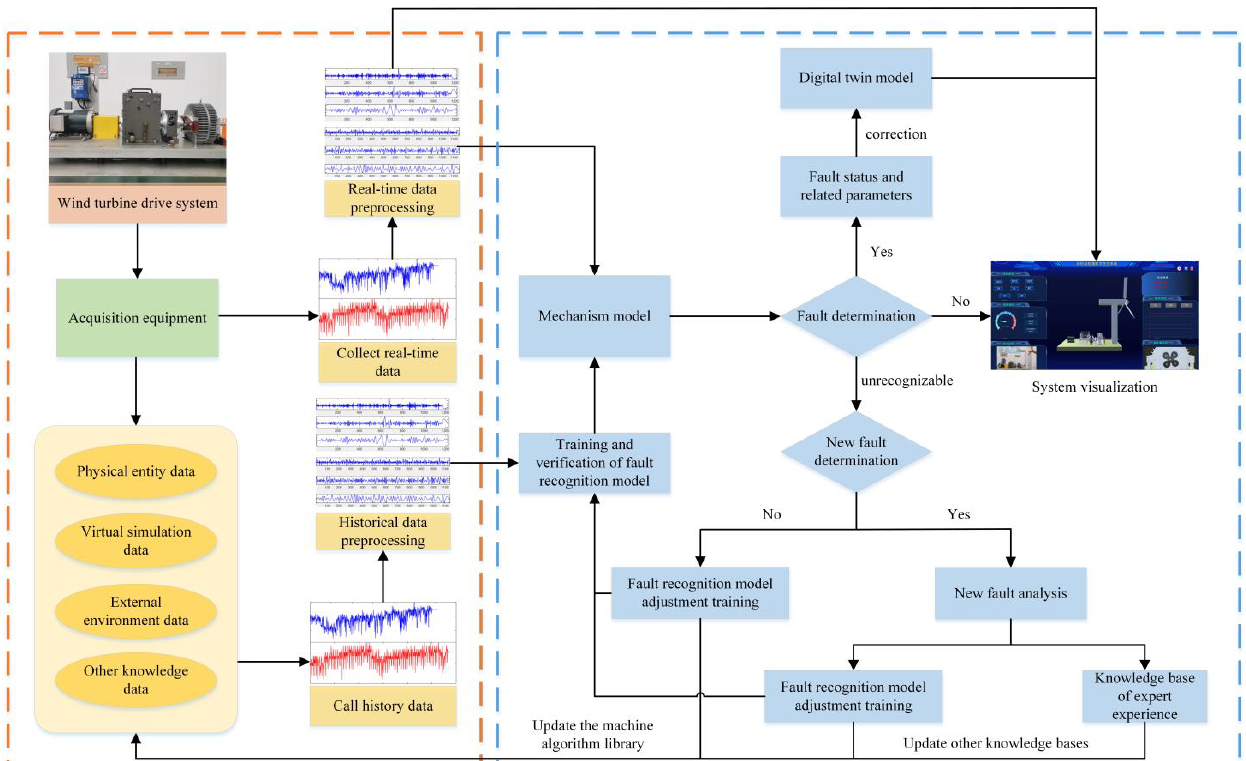
Figure 6. Intelligent diagnosis process for planetary gear of wind turbine.